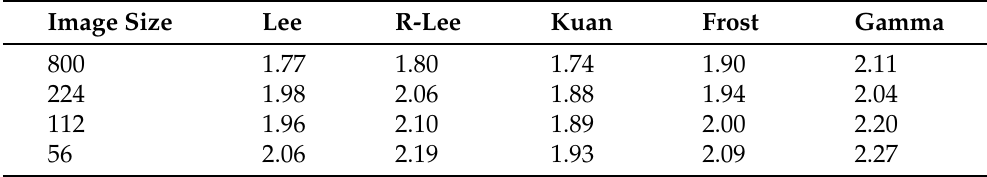
Table 6. The performance of the traditional speckle noise filter, ENL is used as the evaluation index. Image